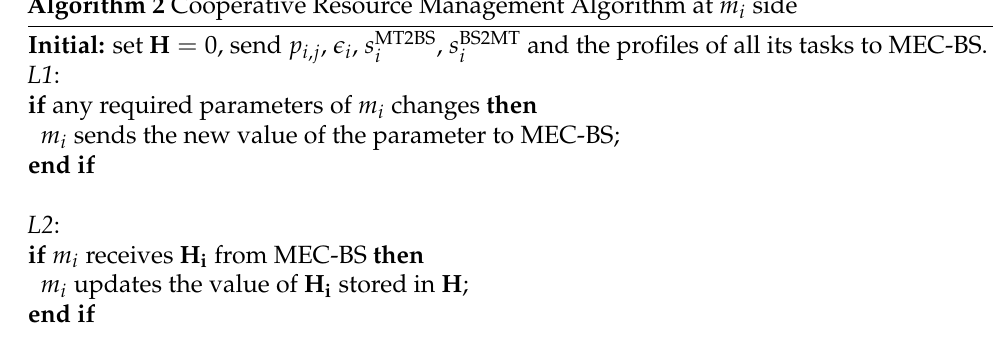
Algorithm 2 Cooperative Resource Management Algorithm at m i